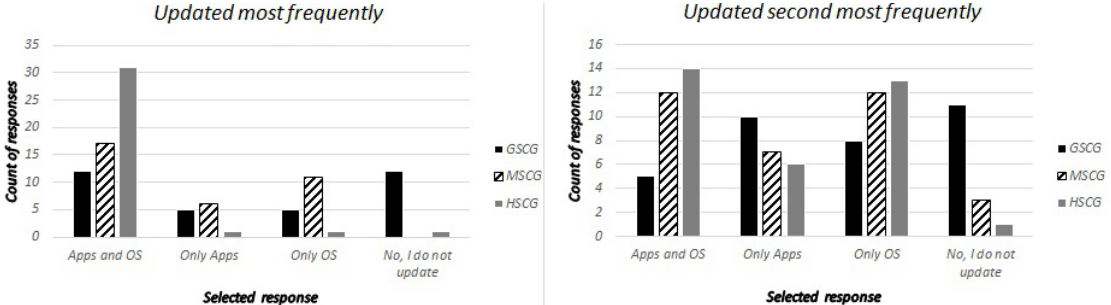
Figure 3. Expert predictions for question